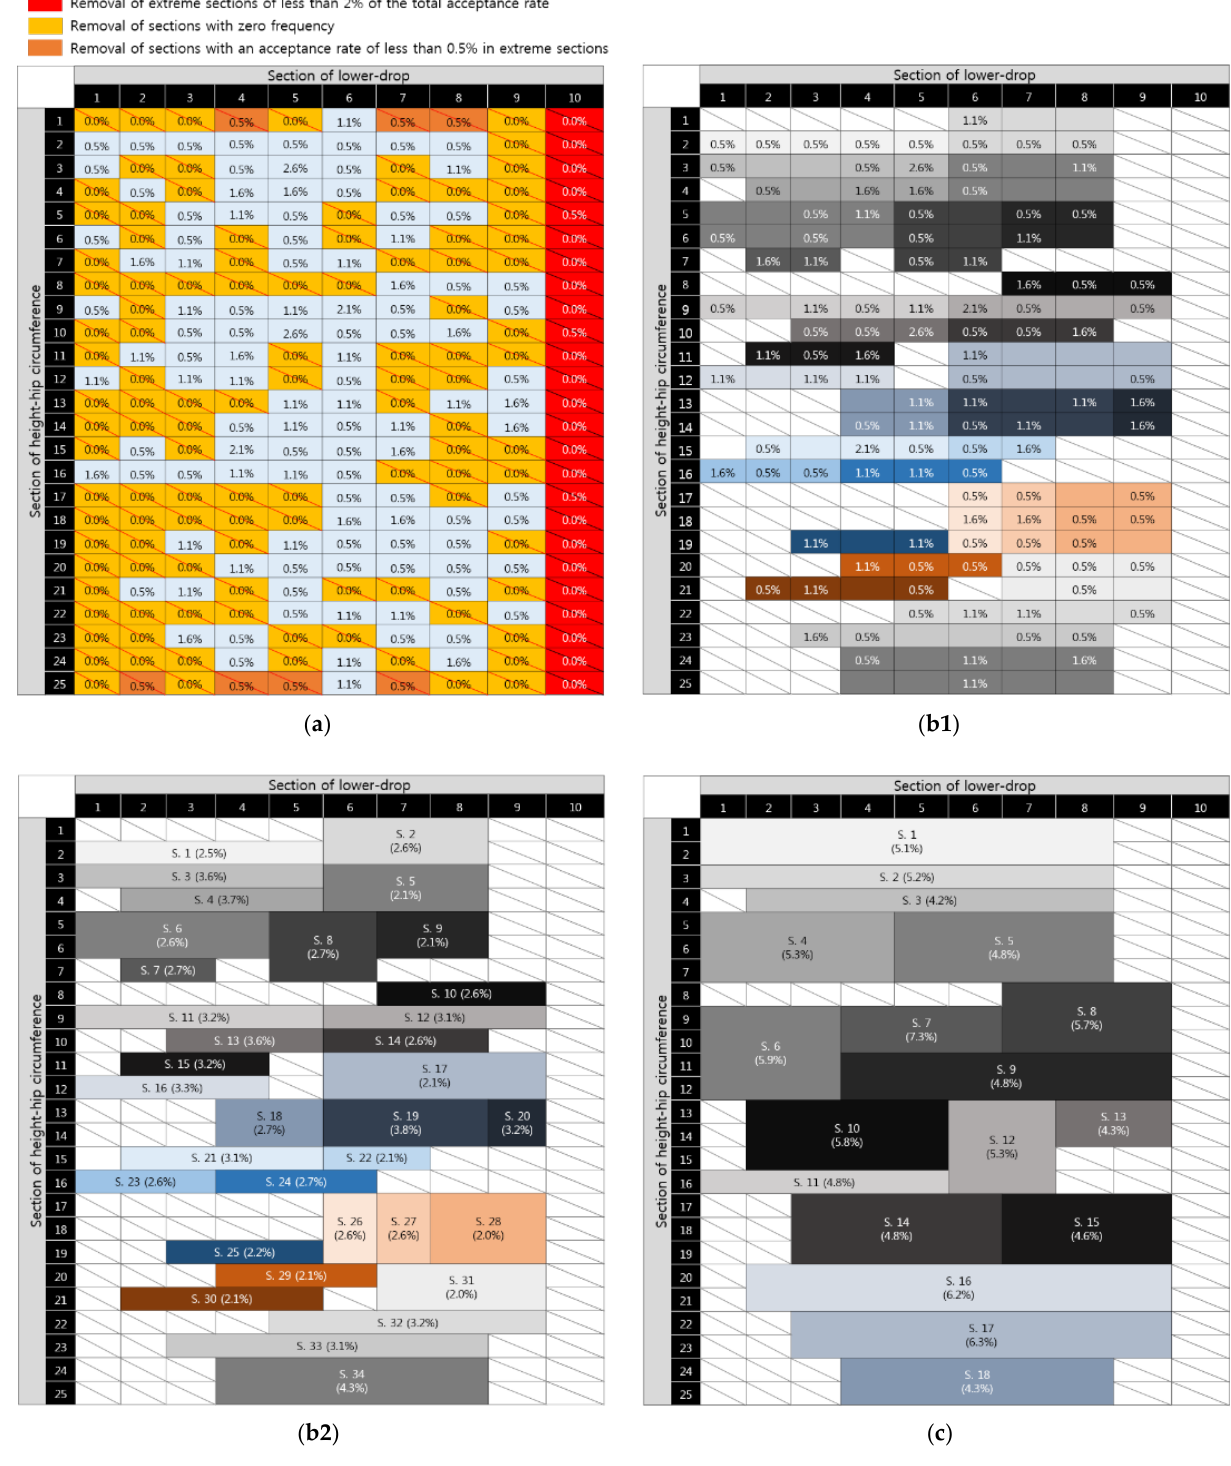
Figure 3. Section removal and grouping process of secondary cross-tabulation: ( a ) section removal; ( b1 ) 1st section grouping — coverage rate-based classification; ( b2 ) 1st section grouping — summation of coverage rates and section numbering; ( c ) 2nd section grouping.